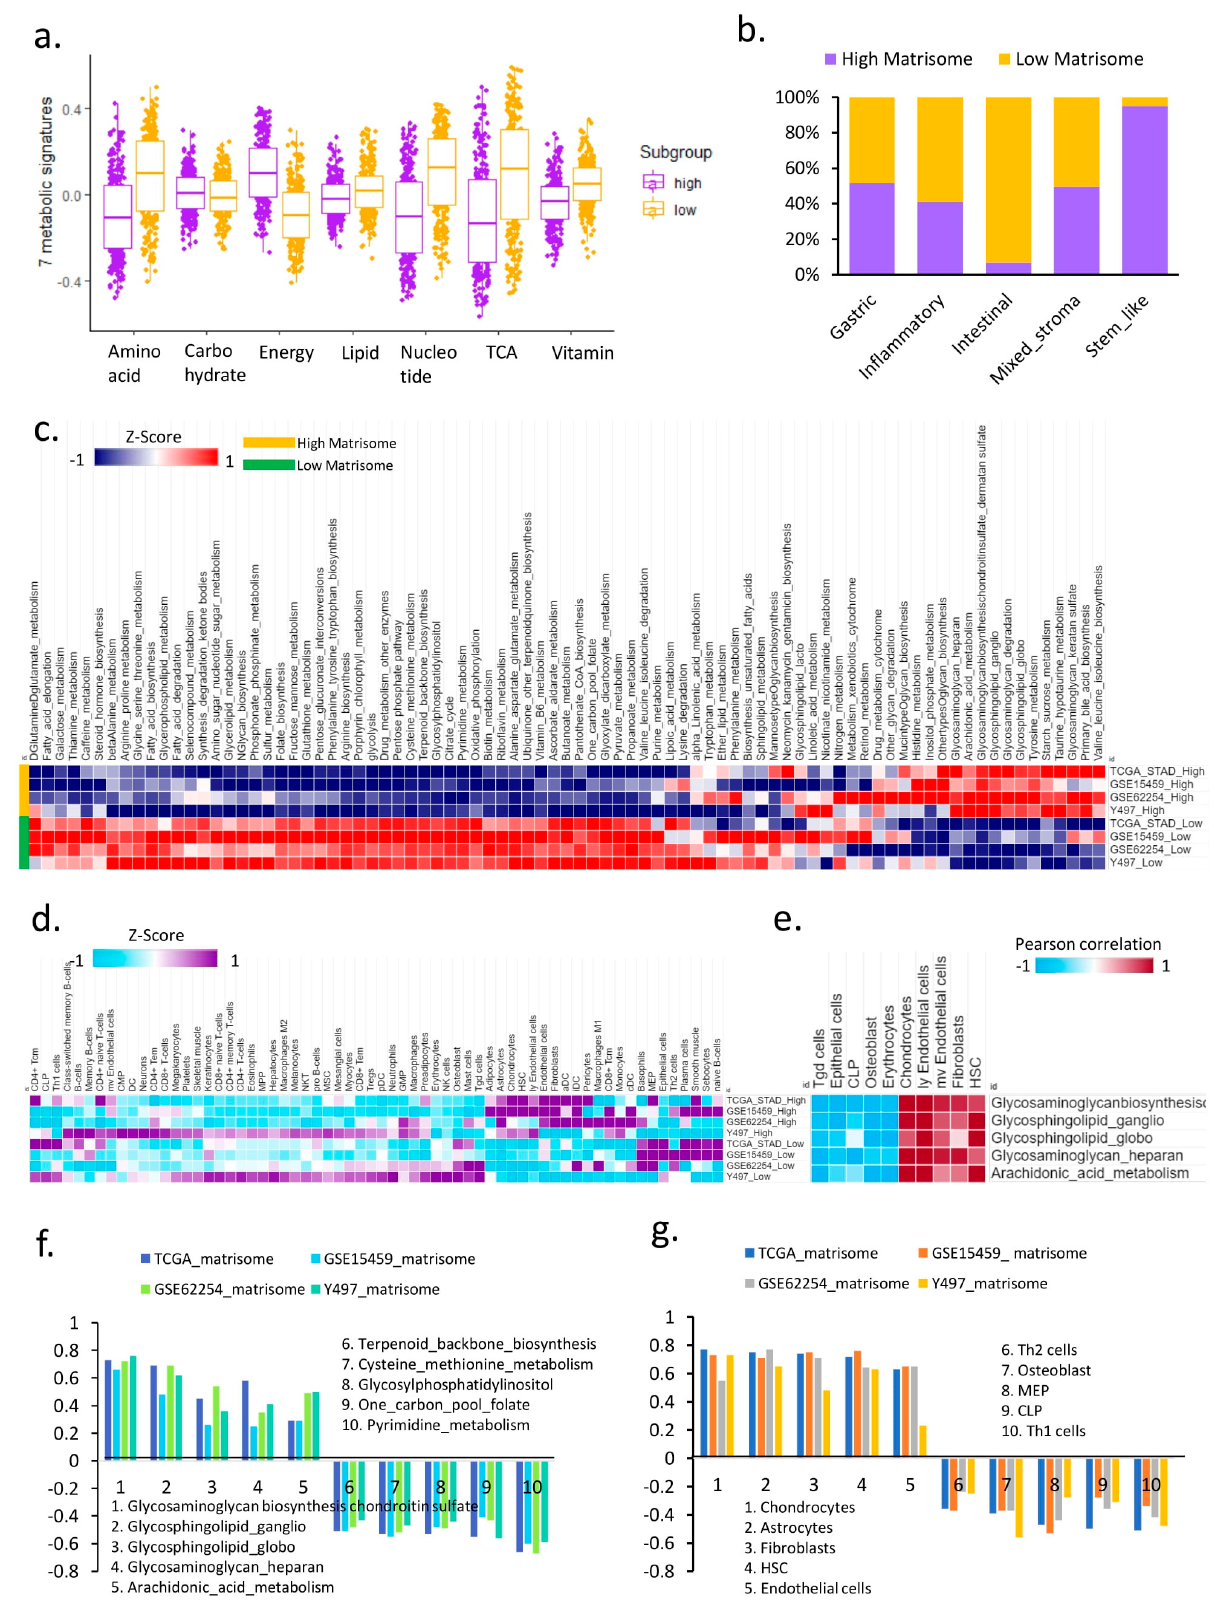
Figure 1. The landscape of metabolic reprograming between high-matrisome and low-matrisome groups. ( a ) Box plot showing seven metabolic signatures between high-matrisome and low- matrisome in the Y497 cohort. ( b ) Bar graph showing matrisome state across five molecular sub- types. ( c ) Heat map showing activity of 83 metabolic pathways in high-matrisome and low-